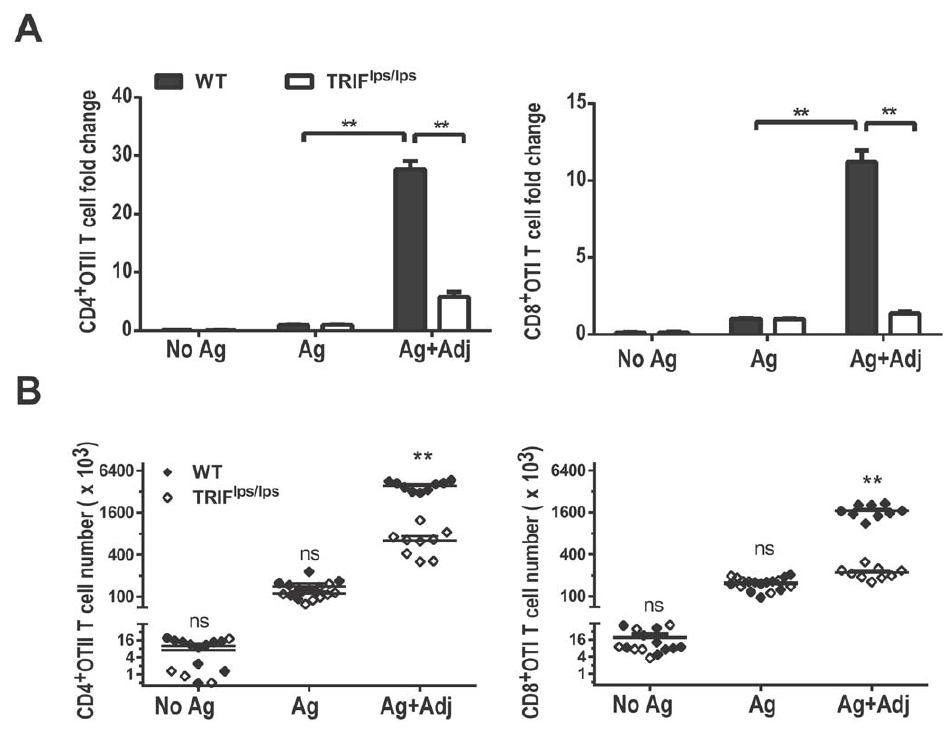
Figure 1. TLR4 mediated adjuvant effects require functional TRIF signal. OTI and OTII T cells were activated in WT or TRIF lps/lps recipients with i.v. injections containing antigen alone (Ag) or antigen plus lipid A (Ag + Adj), or saline (No Ag). Spleens from recipient mice were harvested 96 h after immunization, and B) CD8 + OTI and CD4 + OTII cells were enumerated as described in methods and A) adjuvant effects on T cell clonal expansion were measured by calculating the fold-increase in total OTI or OTII T cell numbers in adjuvanted mice vs. mice given Ag alone. Results are from three independent experiments combining 3 replicates in each experiment (n=9). **;P value , 0.001 between Wt or TRIF lps/lps and ns; not significant.